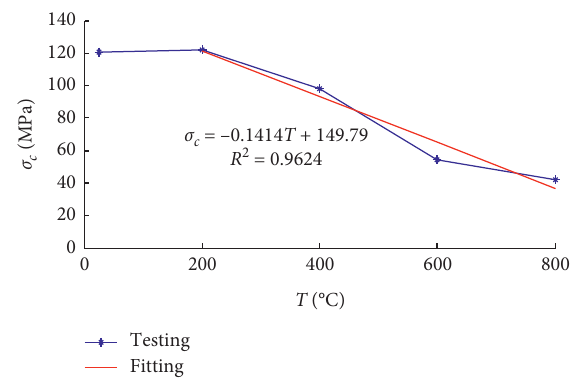
Figure 4: Failure strength-temperature